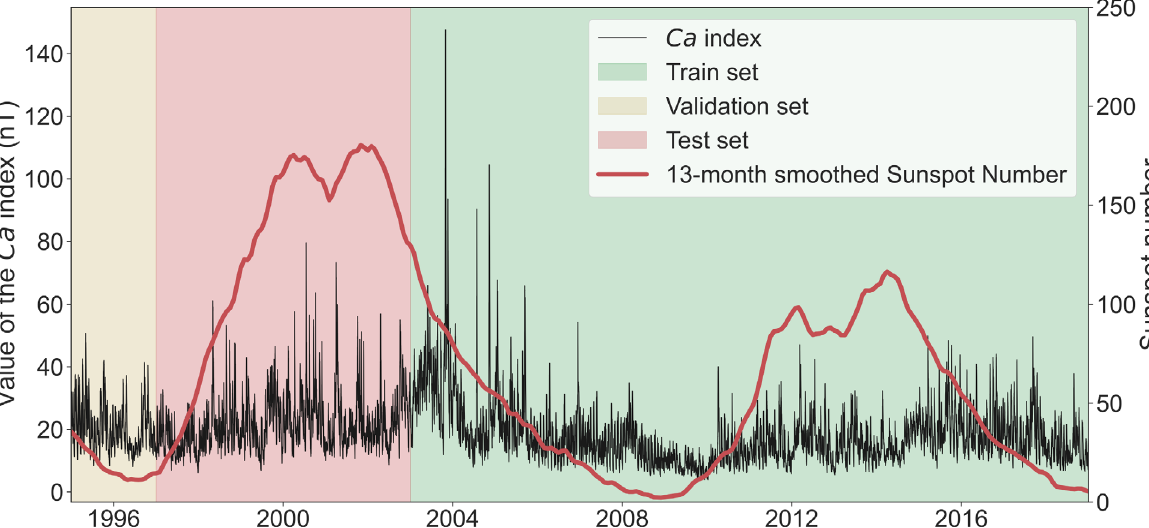
Fig. 2. Plot of the values taken by the Ca index between 1995 and 2018 included (black thin line). The training (green area), validation (yellow area), and test (red area) sets are highlighted. The 13-month smoothed Sunspot Number is also plotted as an indicator for the solar cycle (red thick